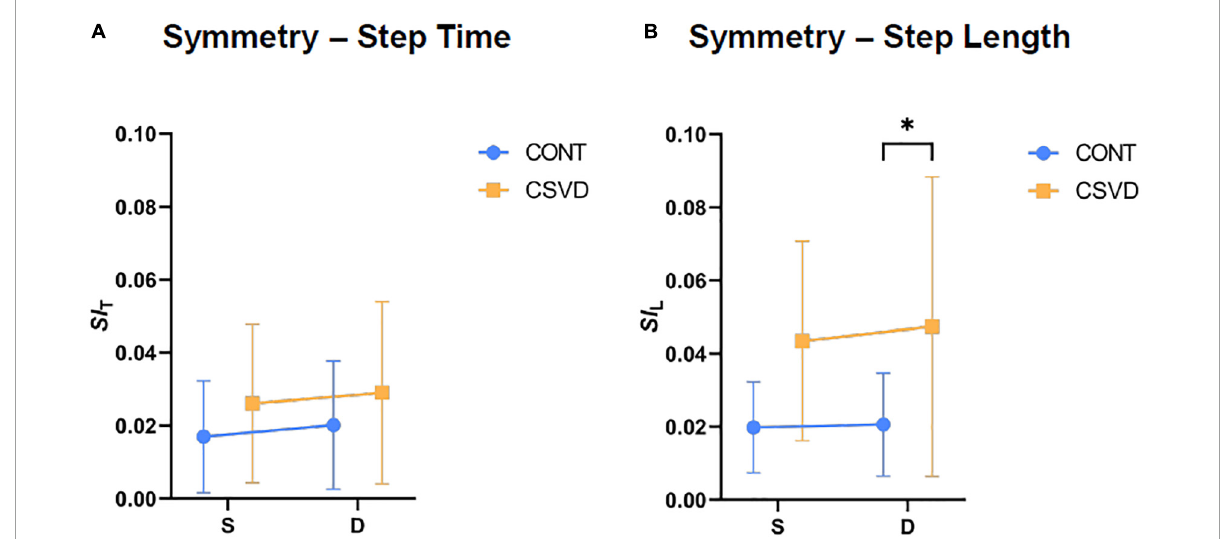
FIGURE3 Gait symmetry is altered by cerebral small vessel disease (CSVD). (A) Symmetry Index of Step Time ( SI T ) is statistically similar (Mann-Whitney test, p > 0.05) between CSVD group ( n = 11; orange square symbols) and age- and sex matched control (CONT, n = 11; light blue circle symbols) for both task conditions. (B) Symmetry Index of Step Length ( SI L ) significantly differs between CONT and CSVD group but only for dual task condition (Mann-Whitney test, p > 0.019). Symbol and error bar depicts mean ± SD. * p < 0.05.